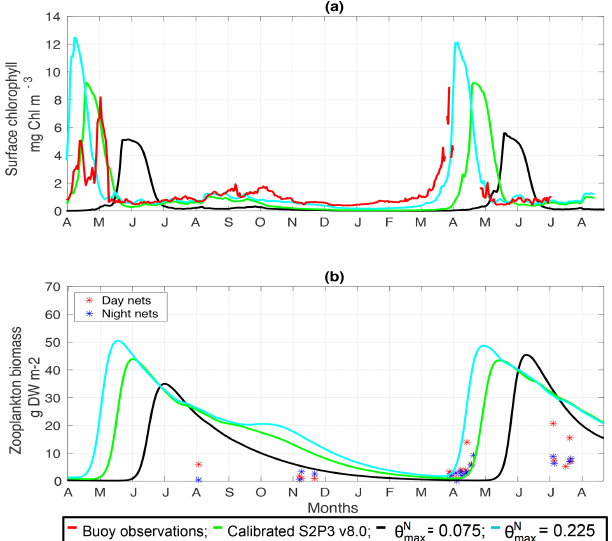
Figure C4. (a) SSB observations of surface chlorophyll a (red line), along with the modelled surface chlorophyll a for the calibrated S2P3 v8.0 model (green line), and experiments m = 0 . 01 (black line) and m = 0 . 03 (cyan line). (b) Observations of zooplankton biomass presented as discrete points for day nets (red dots) and night nets (blue dots) taken during the cruises DY026, DY018, DY029, and DY033; modelled zooplankton biomass from the cal- ibrated S2P3 v8.0 model (green line) and experiments m = 0 . 01 (black line) and m = 0 . 03 (cyan line).